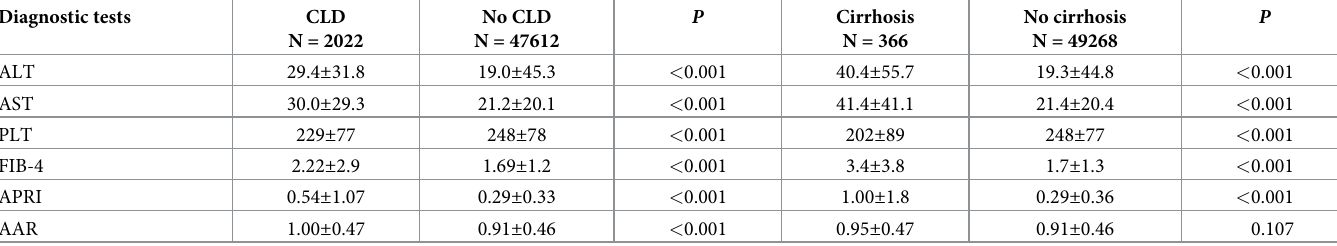
Table 4. Laboratory and fibrosis test results for CLD and